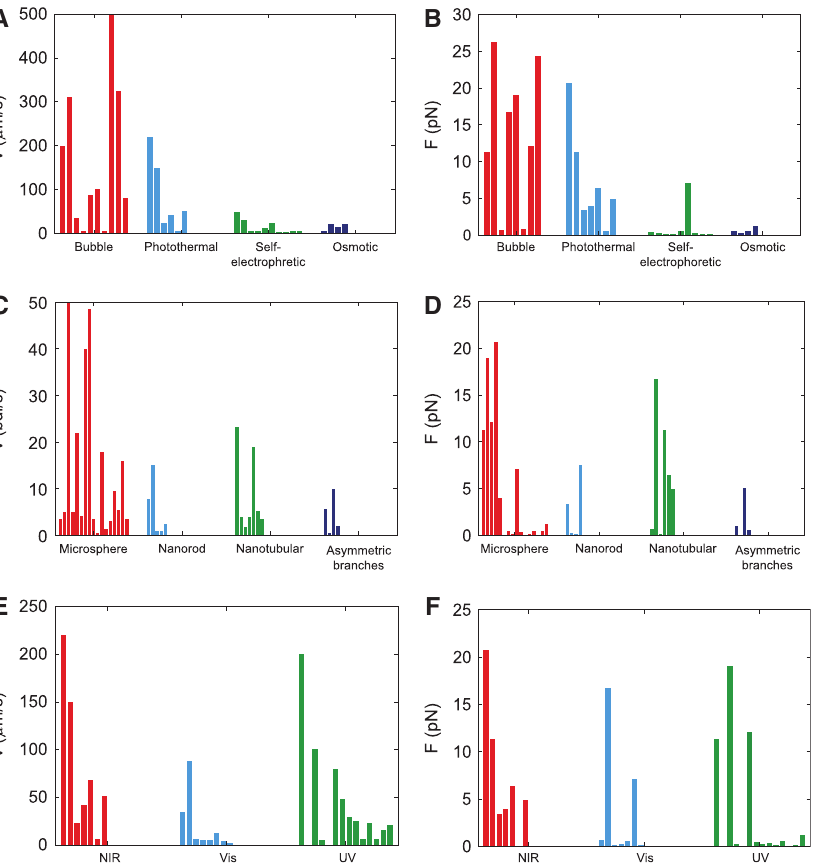
Figure 14: Comparisons of velocity and actuation force with respect to different actuation mechanisms and structures of micro/nanomotors. (A) and (B) present the velocity and force of the reported light-driven micro/nanomotors with four different actuation mechanisms, respectively. Velocity and force for micro/nanomotors with four different structures are displayed in (C) and (D), respectively. Velocity and force for micro/nanomotors with respect to different light wavelengths are compared and shown in (E) and (F), respectively. All the data are the same with those shown in Tables